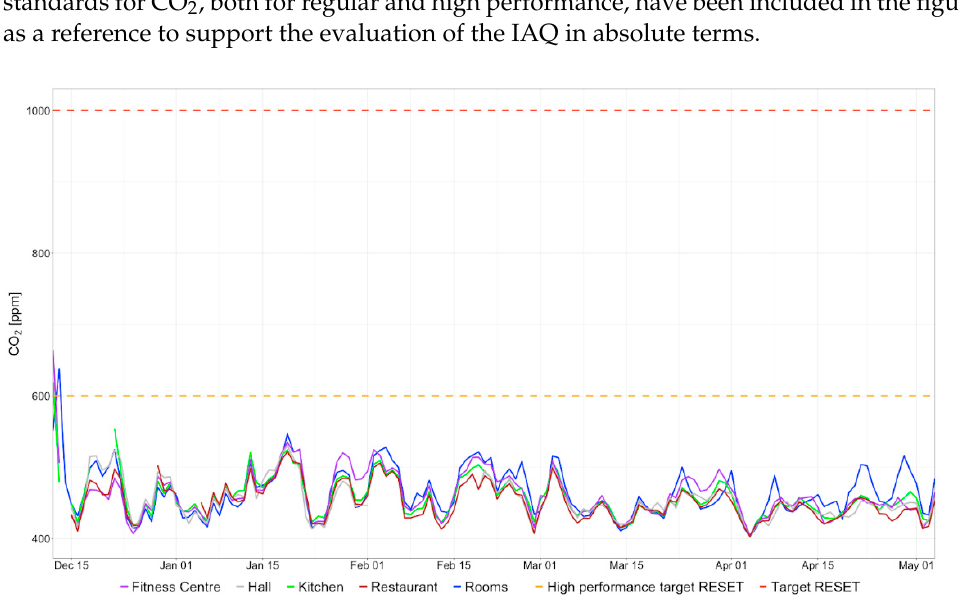
Figure 9. Concentrations of CO 2 (ppm) detected in the different environments monitored across the whole period of analysis. whole period of